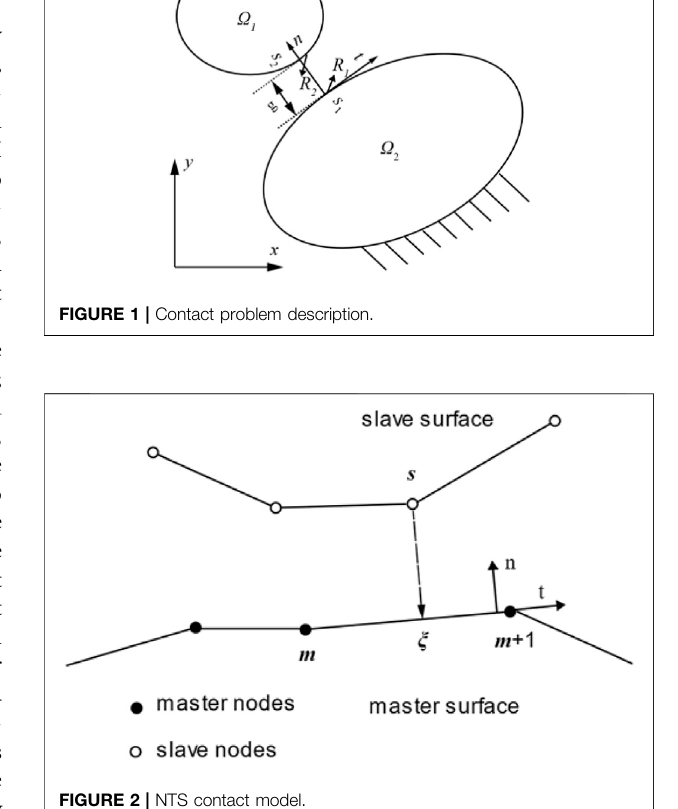
FIGURE 2 | NTS contact